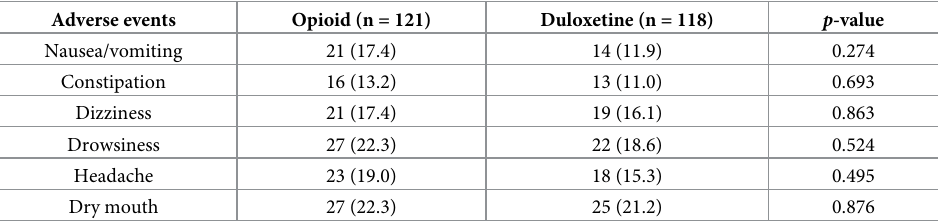
Table 3. Incidences of adverse events �